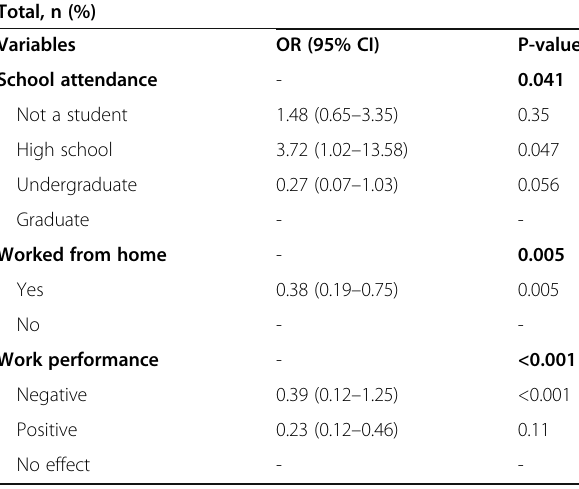
Table 3 Multivariate logistic regression analysis of depressive symptoms